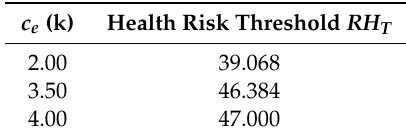
Table 4. Optimal predictive maintenance strategy under di ff erent c e values.